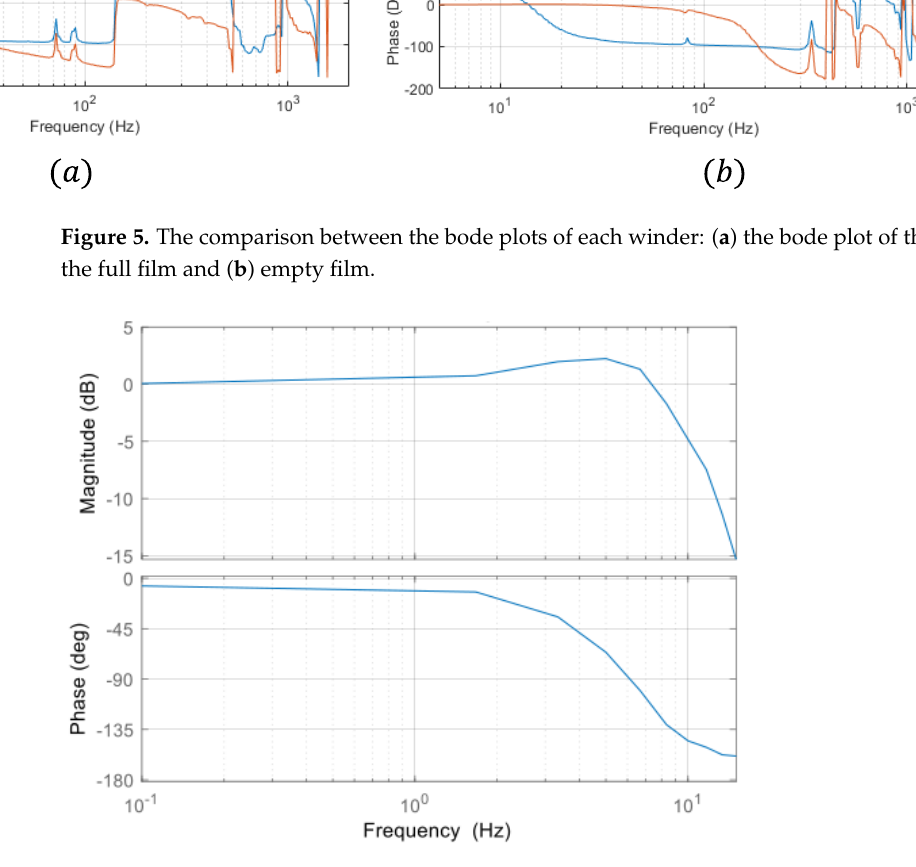
Figure 6. The bode plot of the CLTF for the tension control